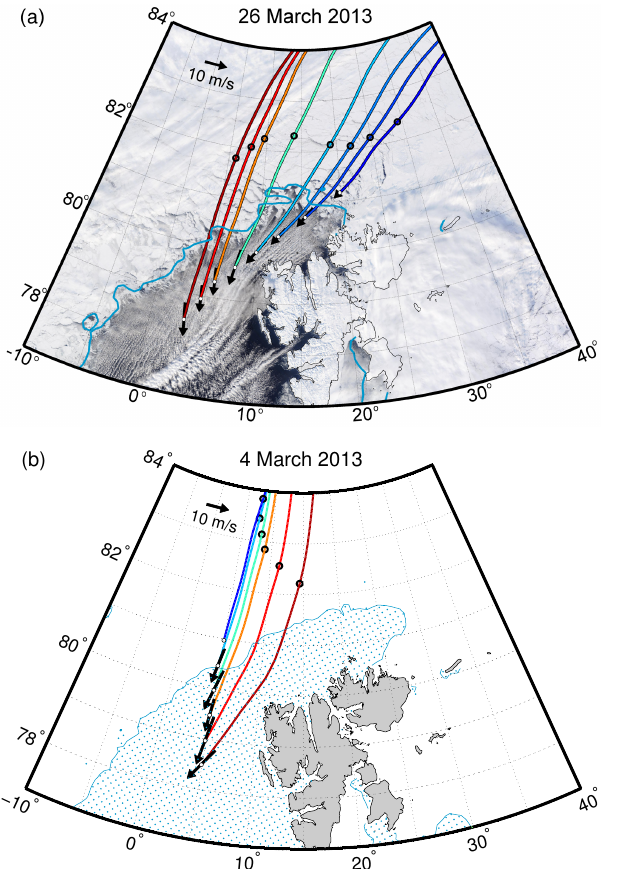
Figure 2. Ice edge based on a 70% threshold value of the SSM/I- ASI ice concentration during days with cold air outbreaks: (a) 26 March and (b) 4 March 2013. The arrows denote the vertically av- eraged wind in the boundary layer at the positions of the dropson- des. The lines are HYSPLIT backward trajectories at 10m height and the dots mark 10h. Background of (a) : MODIS visible image at 12:45UTC (http://lance-modis.eosdis.nasa.gov/cgi-bin/imagery/ realtime.cgi).